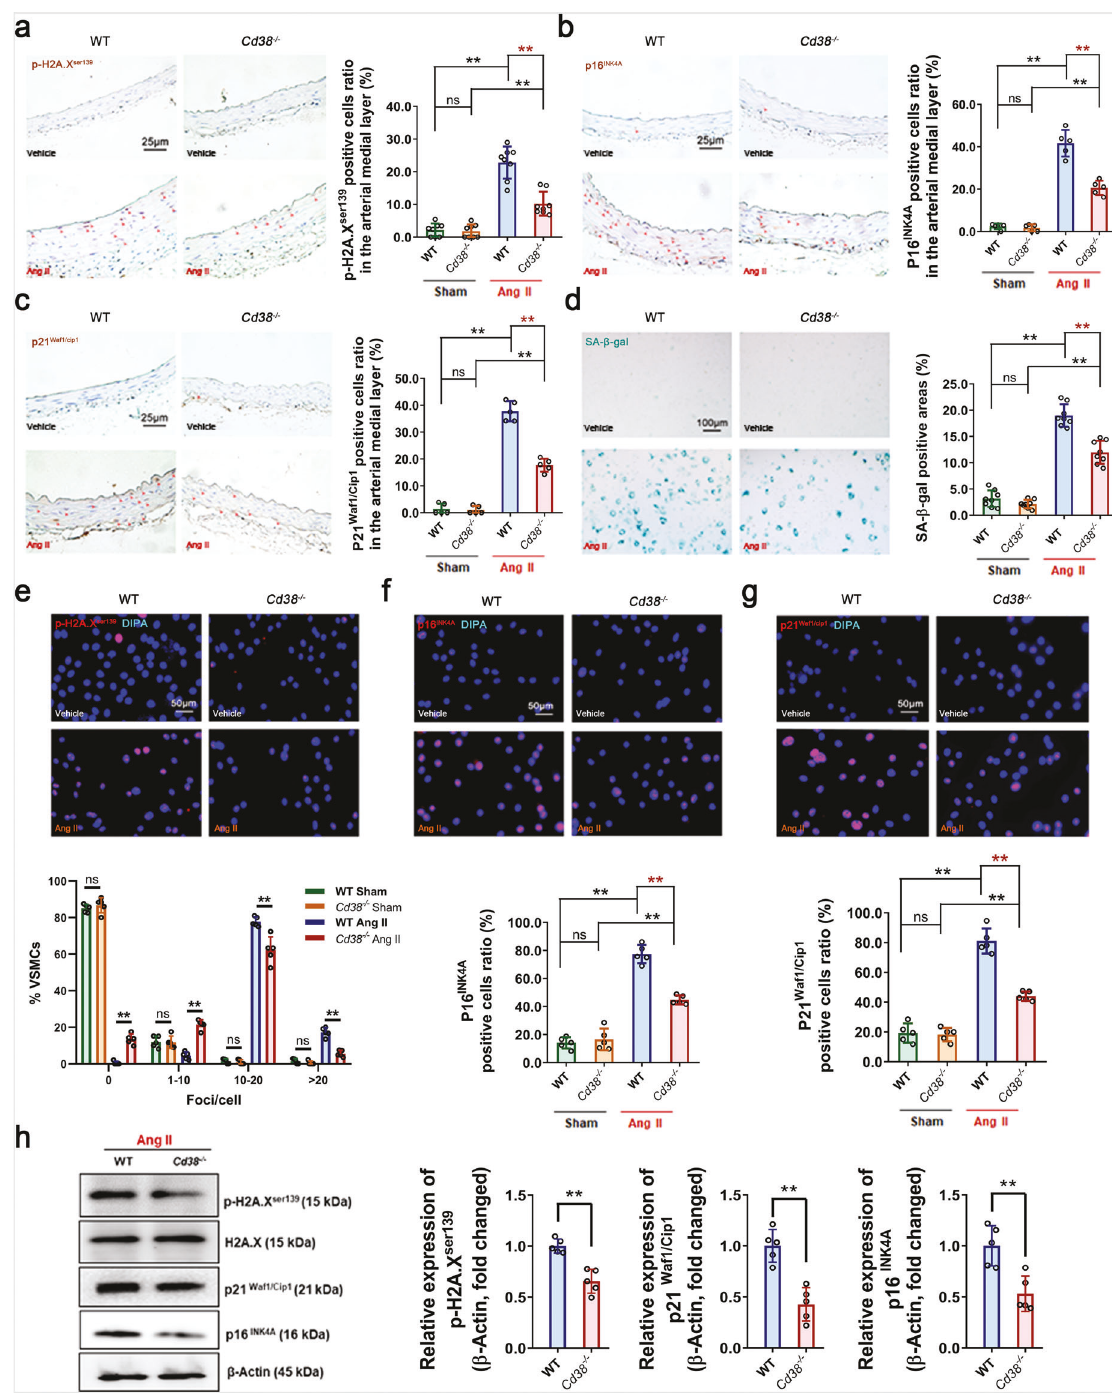
Fig. 2 CD38 de fi ciency alleviated Ang II-induced VSMC senescence. a – c The accumulation of the senescence marker protein p-H2A.X ser139 ( a ), p21 Waf1/Cip1 ( b ), and p16 INK4A ( c ) was analyzed by immunohistochemistry staining of the mouse arterial medial layer with Ang II or saline infusion. The dark reddish-brown dots represented the accumulation of senescence marker proteins in the VSMC nucleus ( n = 8, unpaired t test, * p < 0.05, ** p < 0.01). d SA- β -gal staining showed VSMC senescence with Ang II or Vehicle administration. ( n = 8, one-way ANOVA, * p < 0.05, ** p < 0.01). e – g The expression of the senescence marker protein p-H2A.X ser139 ( e ), p21 Waf1/Cip1 ( f ), and p16 INK4A ( g ) was analyzed by immuno fl uorescence staining in Ang II-challenged VSMCs. ( n = 8, unpaired t -test, * p < 0.05, ** p < 0.01). h The expression of senescence- associated proteins in VSMCs with Ang II administration was detected by western blot assay ( n = 5, unpaired t -test, * p < 0.05, ** p < 0.01). Ang II (100 μ M) was added to the cell medium for 3 days, the senescent cells were stained, and the protein levels were analyzed